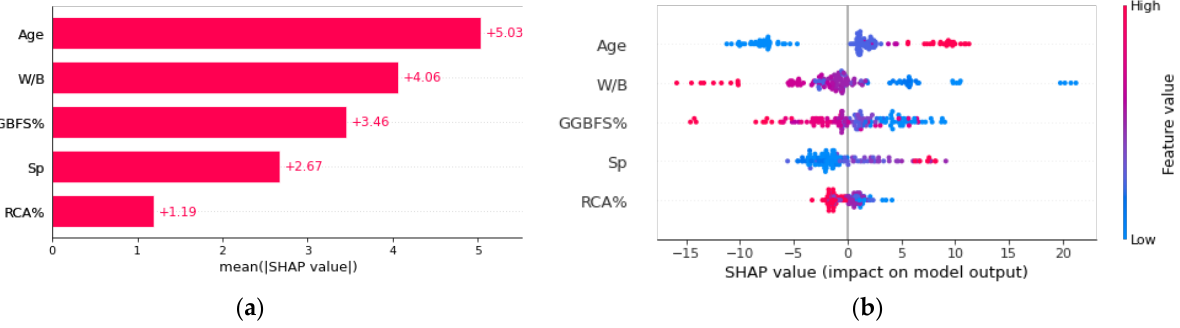
Figure 9. The relative importance of each feature and SHAP summary plot: ( a ) relative importance; ( b ) SHAP summary plot.